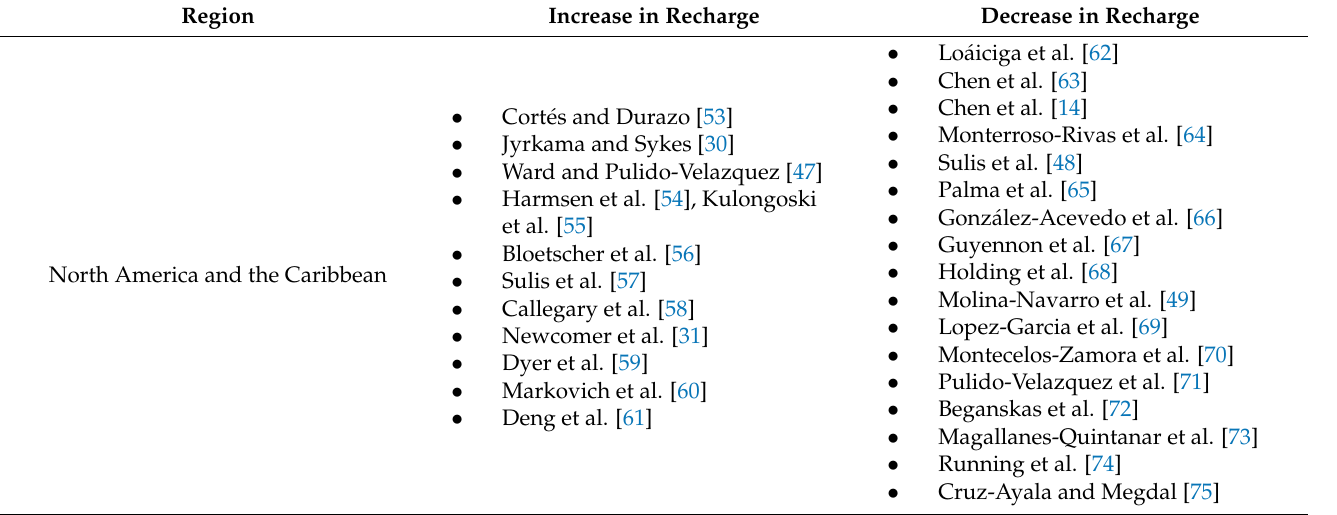
Table 1. Scientific production identified for North America and the Caribbean.